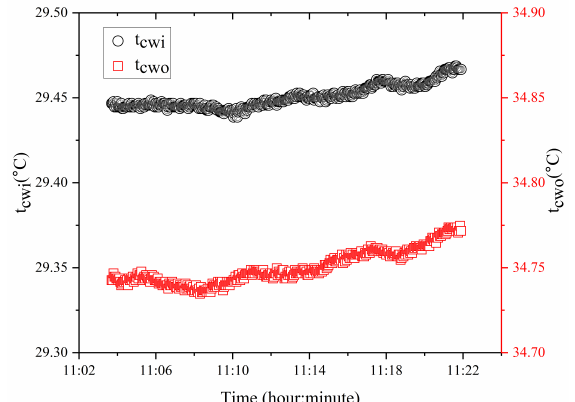
Figure 5. Condenser inlet and outlet water temperature at 700 RT and 581 kg